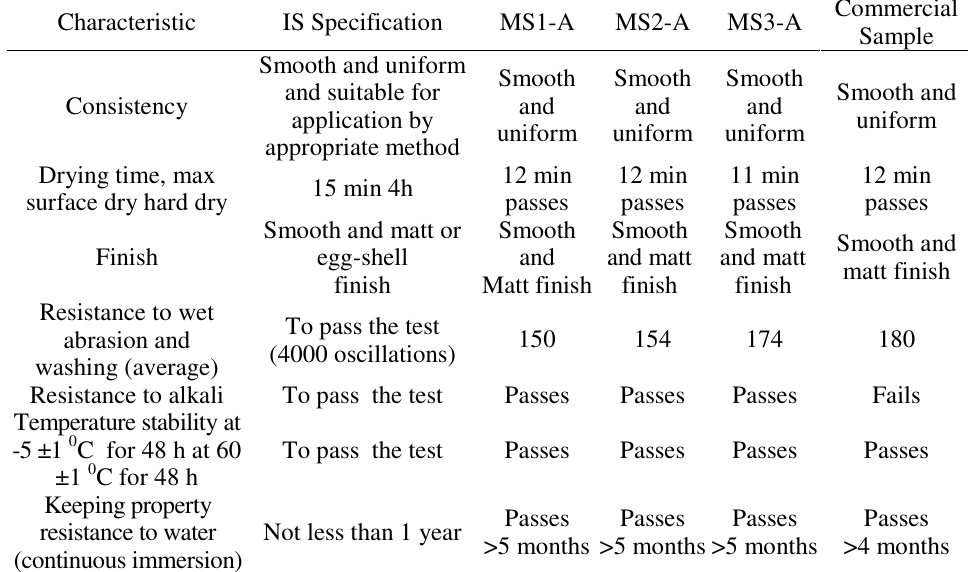
Table 3. Characteristics of maleated shellac acrylic resin based water thinkable composition and commercial